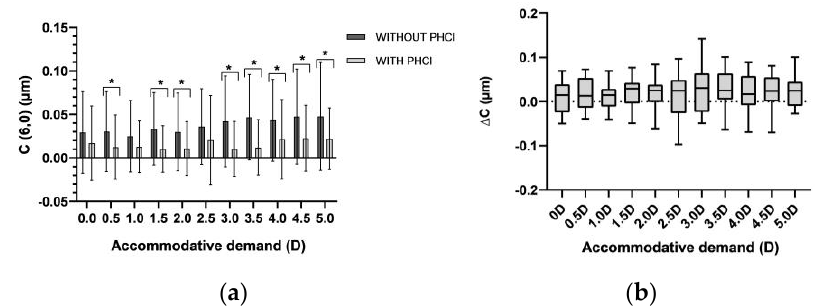
Figure 6. ( a ) Secondary spherical aberration Zernike coefficients for the different target accommodations, with and without PHCl (grey and black, respectively). ( b ) Box plot of the difference in Zernike coefficients between natural conditions and after instillation of PHCl for each accommodative demand. * Denote statistically significant values ( p < 0.05). Error bars represent the standard deviation (SD).